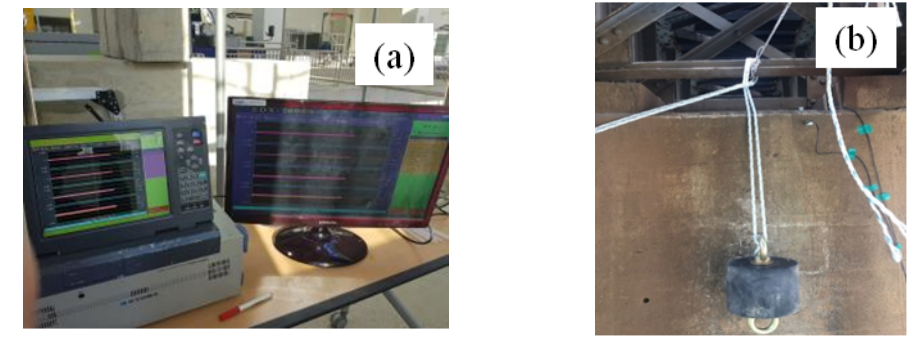
Figure 3. Equipment used in the experiment. ( a ) Data logger and ( b ) weight.